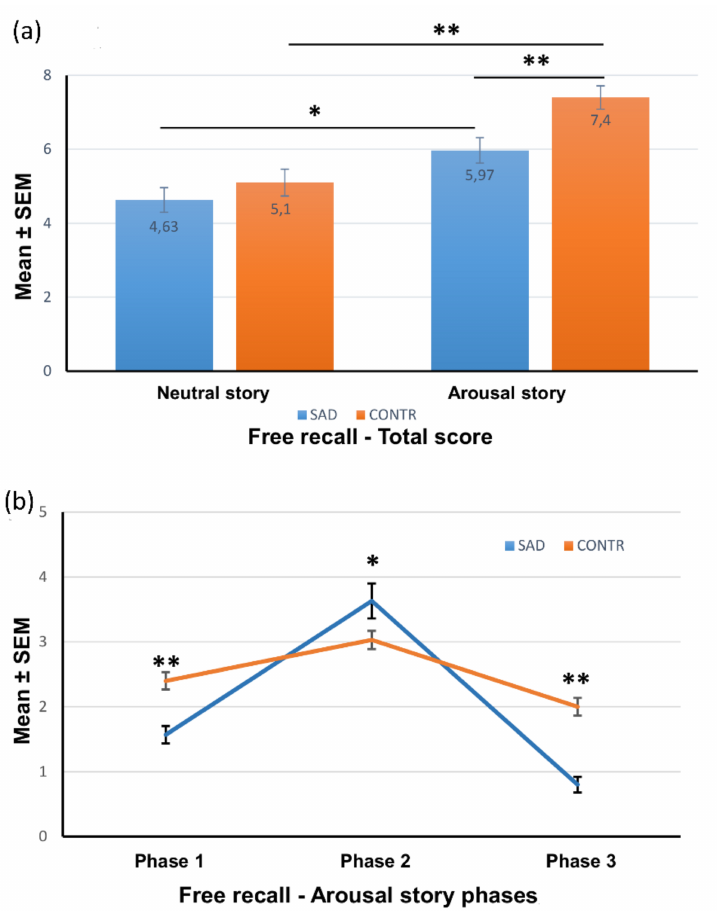
Figure 3. Free recall scores. ( a ) Score (mean ± SEM) of the total story recall of the participants under neutral and arousal conditions. * p < 0.01; ** p < 0.001. ( b ) Recall scores (mean ± SEM) for each phase of the story, in subjects assigned to the arousal condition. * p < 0.05; ** p <